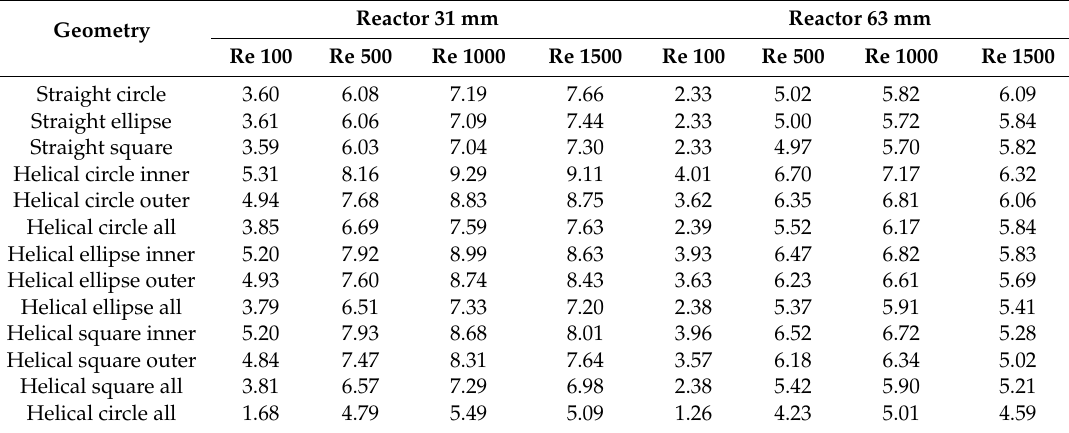
Table 7. Figure of Merit (FoM) for a single channel VAM reactor (Watt per mg of